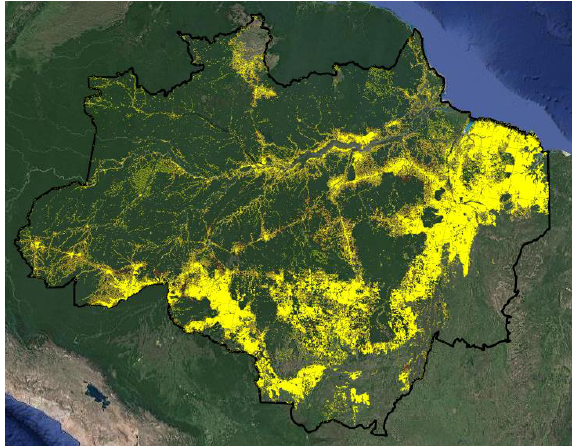
Figure 1. Removal of primary forest vegetation in the Legal Amazon (yellow polygons) until 2018 according to PRODES in data production.